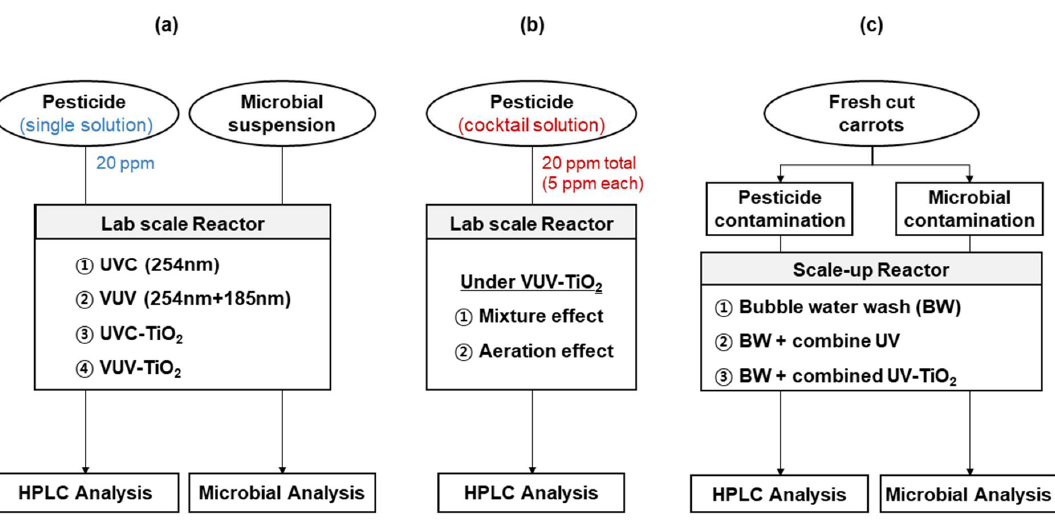
Figure 1. Experimental flow charts. ( a ) experiments to investigate the effect of the UV light source and TiO 2 photocatalysis on degradation of pesticides and microorganisms. ( b ) Experiments to investigate the effects of mixture compounds and aeration condition on the degradation efficiency of pesticides cocktail under VUV-TiO 2 . ( c ) Experiments to investigate the removal effect of residual pesticide and microorganisms from carrot samples.